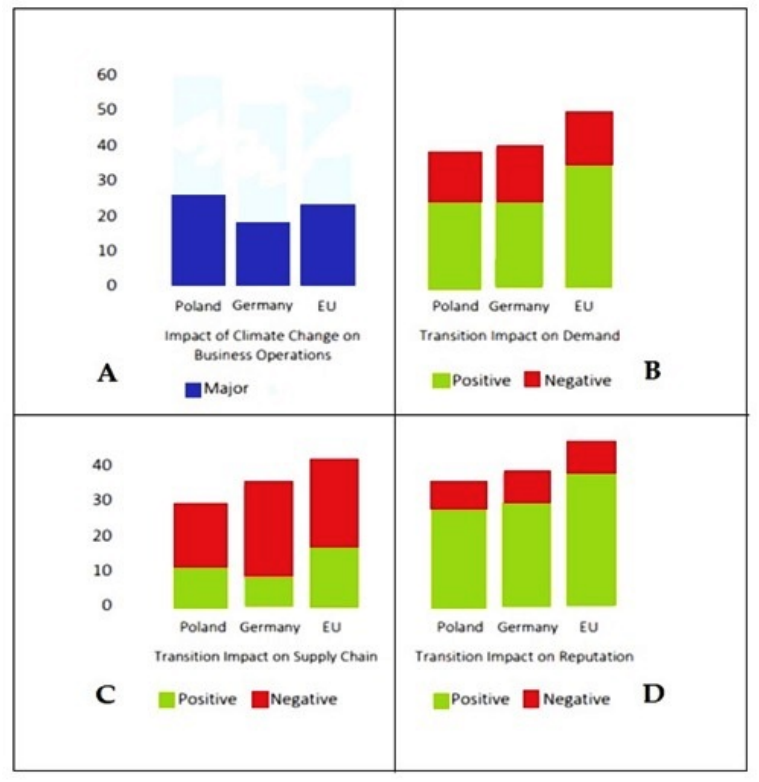
Figure 16. ( A – D ) Ways of interpreting climate change (%).